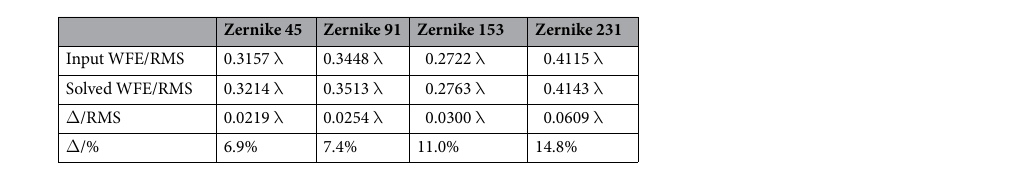
Table 1. WFE simulation results based on the use of high-order Zernike